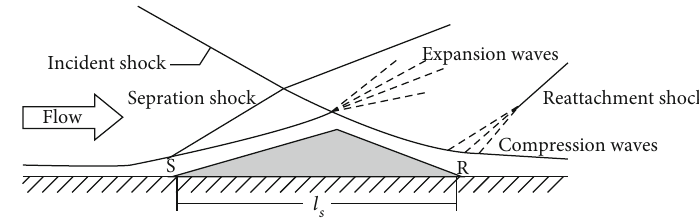
Figure 1: Schematic description of incident shock induced boundary layer